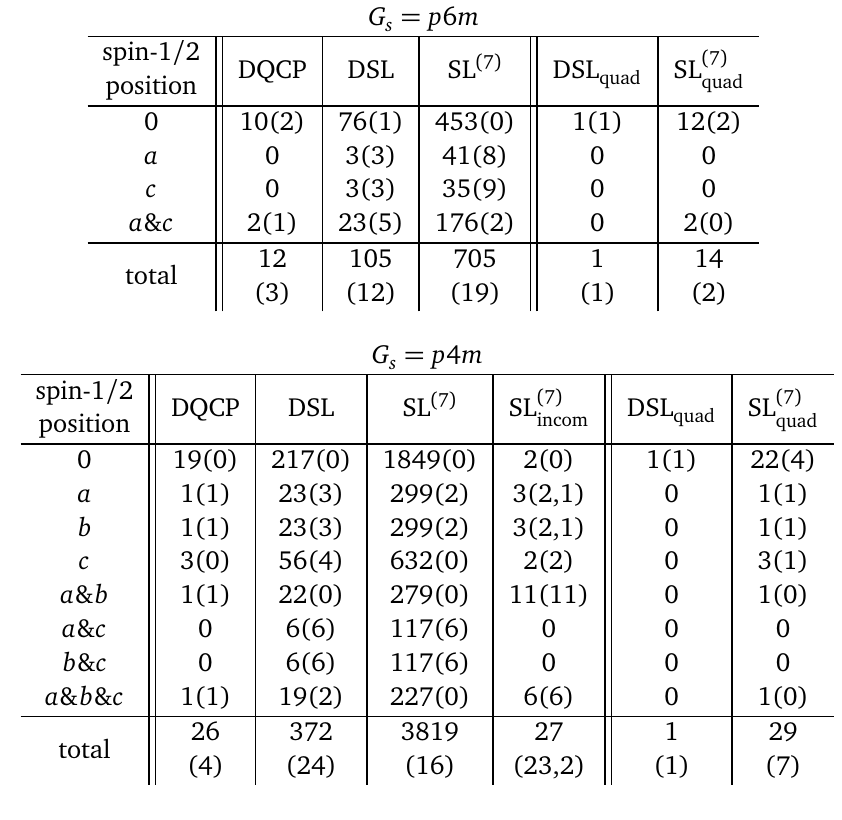
Table 1: Numbers of realizations for DQCP, DSL and SL ( 7 ) in spin systems with a p 6 m (upper) or p 4 m (lower) lattice symmetry. Two realizations with symmetry ac- tions related by a similarity transformation are considered as a single